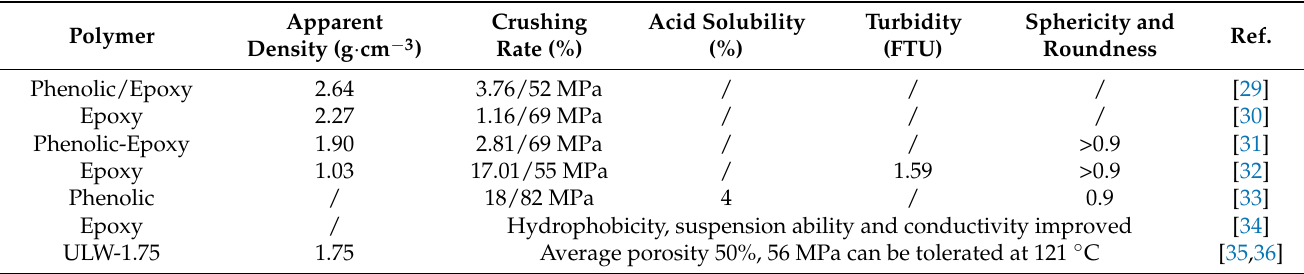
Table 5. Properties of polymer coated synthetic ceramic proppant.